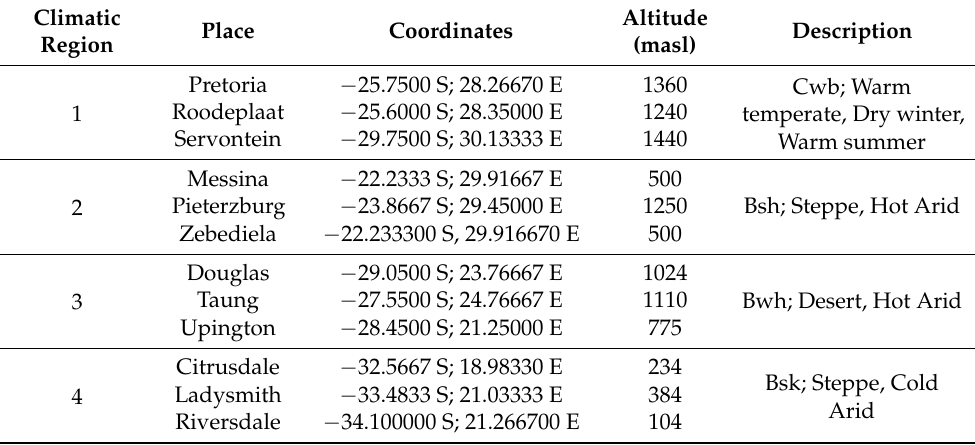
Table 1. The selected four agroecological regions of South Africa are classified according to the Köppen–Geiger classification system